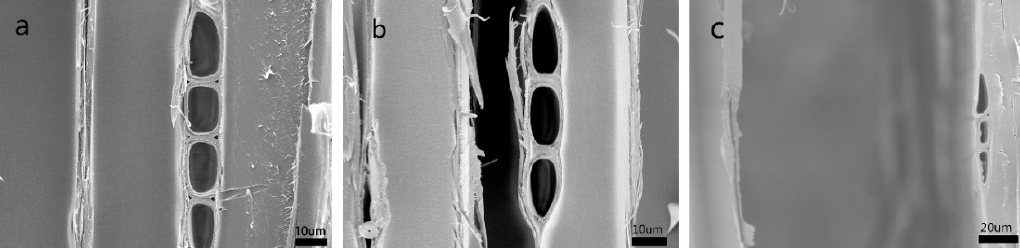
Forests 2020 , 11 , x FOR PEER REVIEW